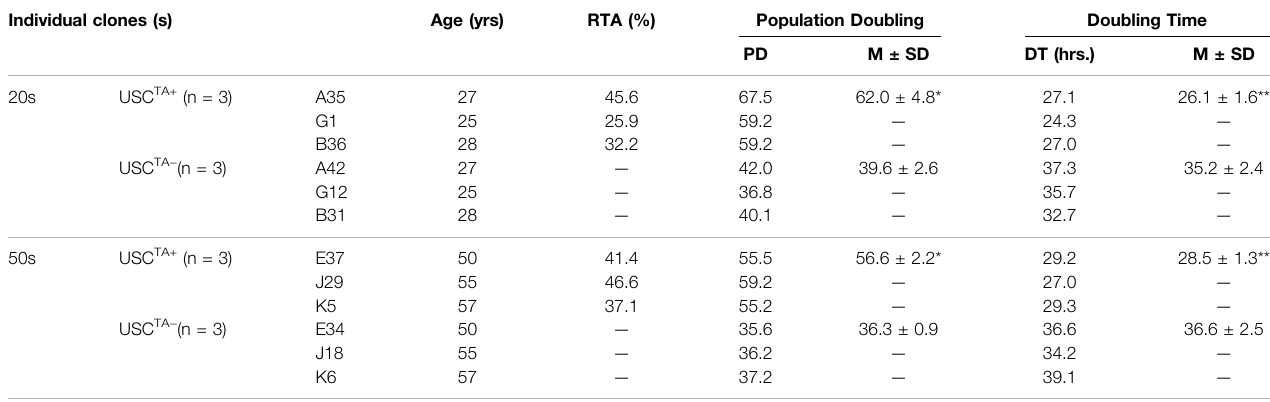
* p < 0.001: USC TA+ vs USC TA − in, population doubling at age of 20s, and 50s groups, respectively. ** p < 0.01 : USC TA+ vs USC TA − in, doubling time at age of 20s, and 50s groups, respectively. The suf fi xes A, B, G, C, H, D, E, F, J, and K represent the ten healthy individuals who participated in the study.